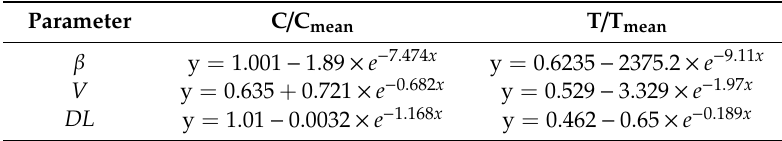
Table 3. Fitting functions with di ff erent